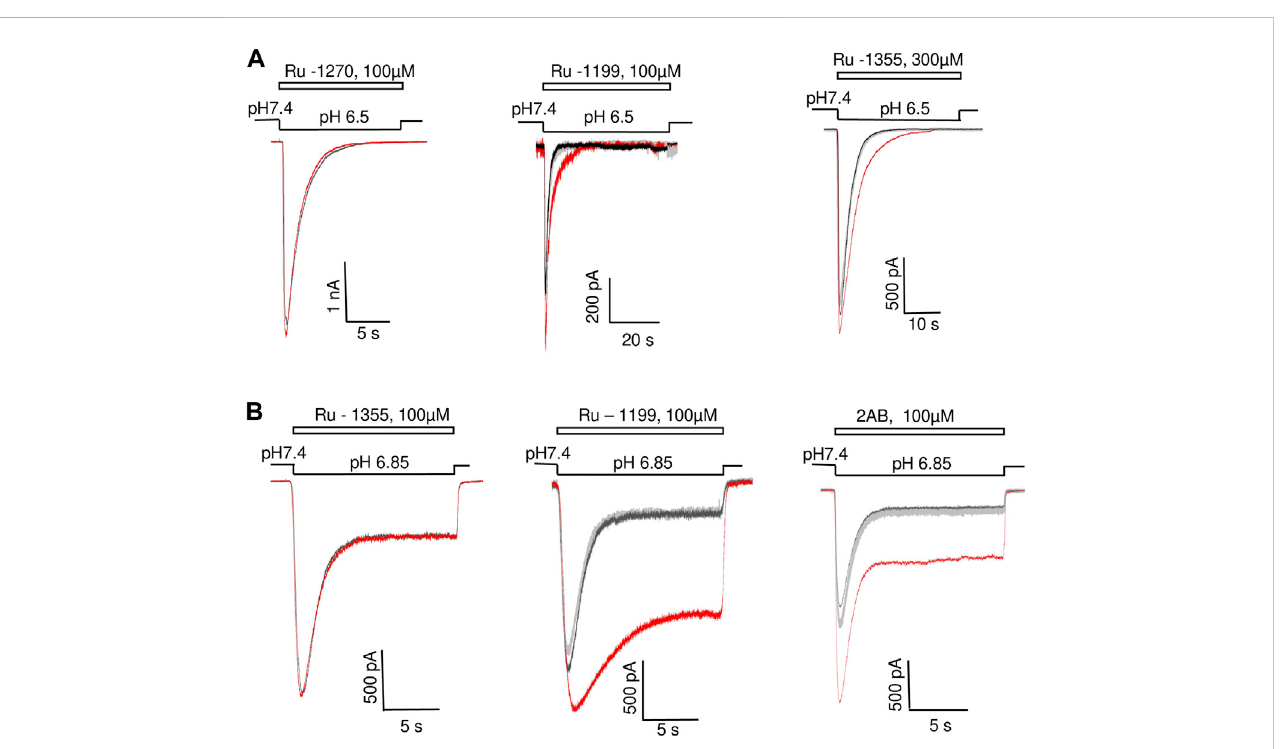
FIGURE 2 Action of 2-aminobenzimidazole derivatives on ASIC1a (A) and ASIC3 (B) . Responses in the control condition are shown in black; responses in the presence of the drug are shown in red; responses after drug washout are shown in gray. A, Ru-1270 is inactive. Ru-1199 potentiates the response amplitude and slows down the decay of the ASIC1a response. Ru-1355 (300 μ M) does not signi fi cantly affect the response amplitude, but slows down the kinetics of desensitization. B, Ru-1355 is inactive, whereas Ru-1199 and 2-AB potentiate both the peak and steady-state components of the ASIC3